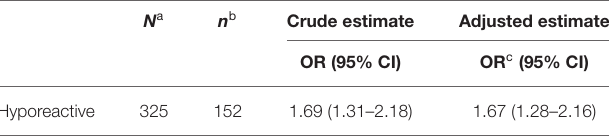
TABLE 7 | Odds ratio (OR) and 95% confidence intervals (CI) of the association between attempted suicide at baseline and hyporeactivity. N a n b